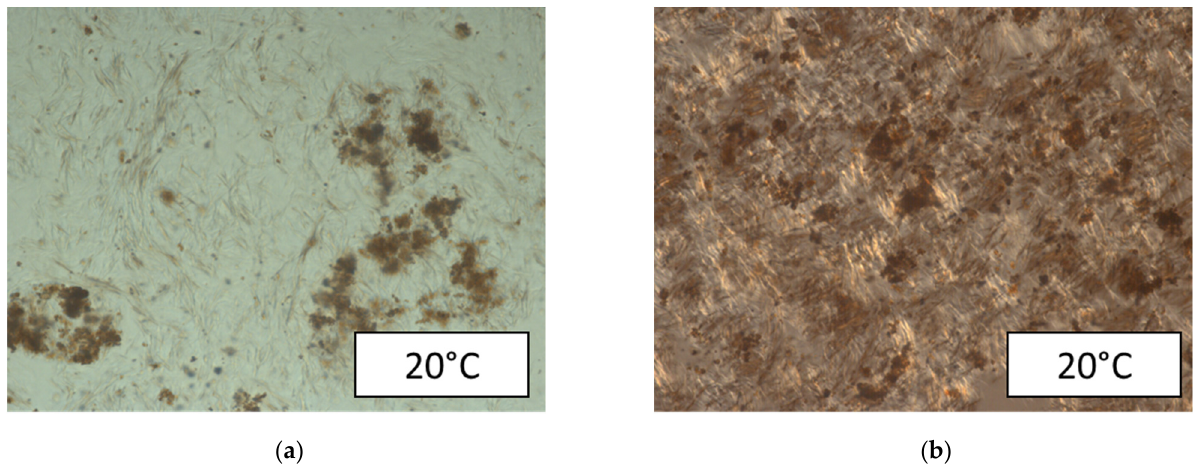
Figure 6. CPM images at 20 °C of oils ( a ) 2A and ( b ) 3A. Wax crystals were not observed for oil 1A under the same conditions.